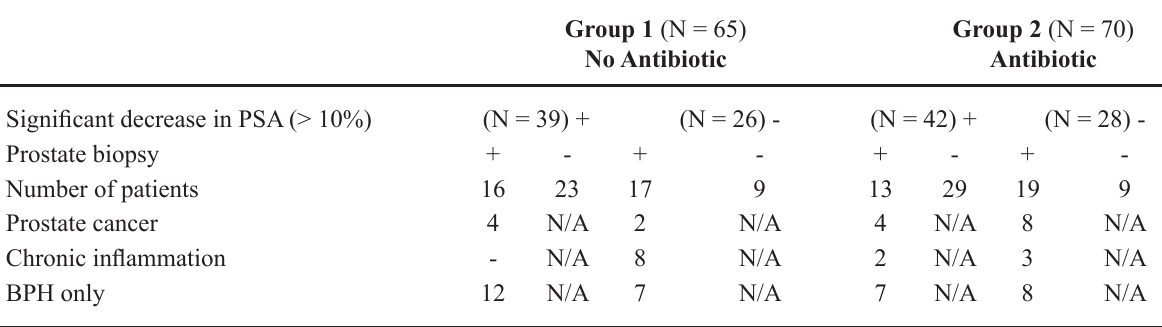
Table 1 – Results of PSA changes and prostate biopsies in 135 patients.